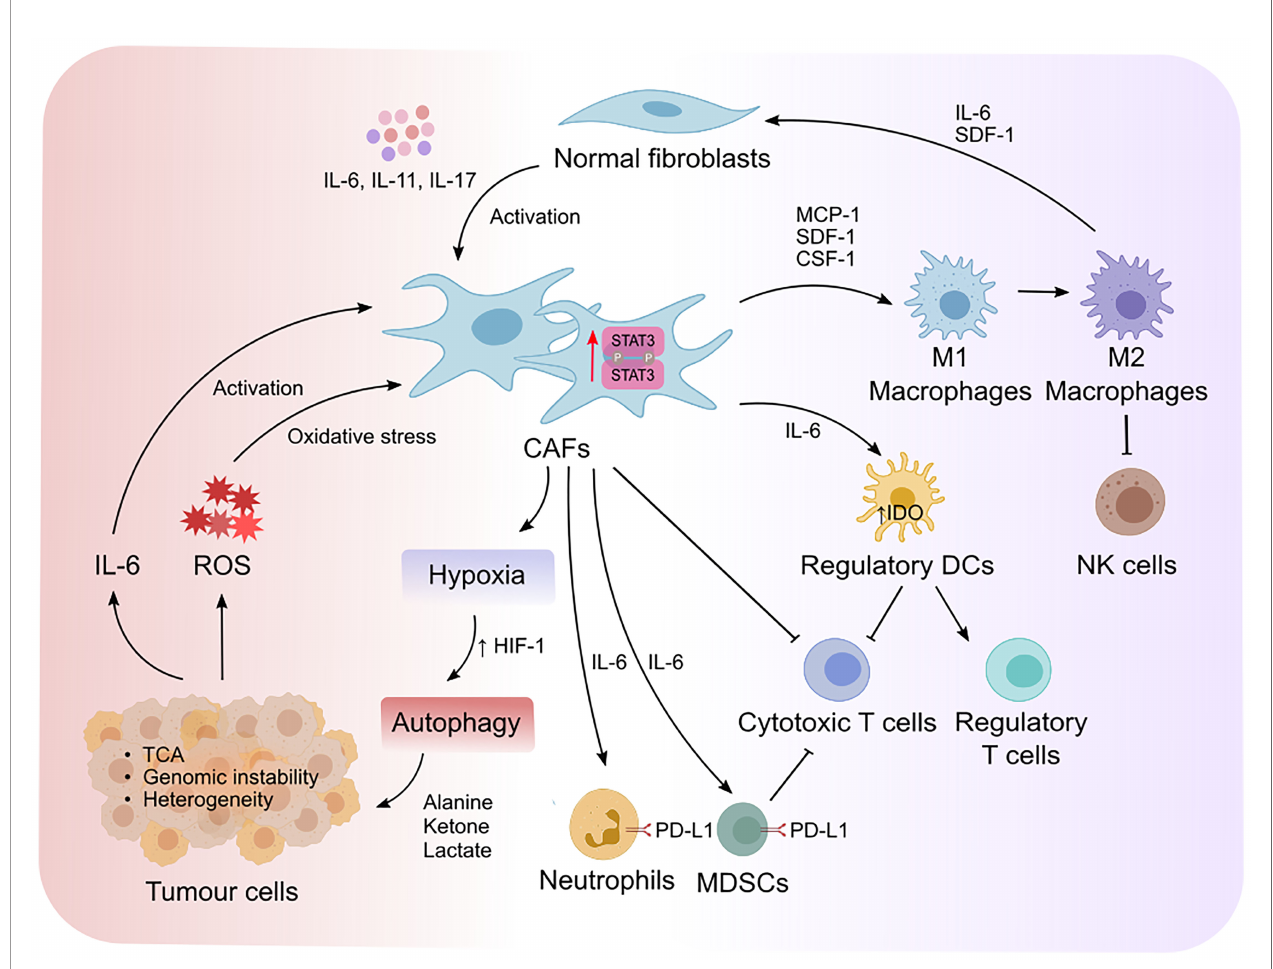
FIGURE 3 | STAT3 mediates reciprocal crosstalk between CAFs, tumor cells and immune cells in the TME. Cytokine-mediated activation of STAT3 promotes the transformation of normal fi broblasts to cancer associated fi broblasts (CAFs). STAT3 increases the expression of hypoxia-inducible factor-1 (HIF-1) that leads to hypoxia and autophagy. This results in the production of high energy products that fuel the tricarboxylic (TCA) cycle in tumor cells, as well as the production of IL-6 that form a positive feedback loop to enable further activation of CAFs. Moreover, elevated oxidative stress induced by tumor-derived reactive oxygen species (ROS) can induce genomic instability and promote tumor heterogeneity. On the other hand, STAT3-mediated activation of CAFs exert immunosuppressive effects via the recruitment and polarization of macrophages from an M1 to an M2 endotype, which suppresses the cytotoxic activity of natural killer (NK) cells. Moreover, CAFs recruit regulatory dendritic cells (DCregs) to inhibit the activation of cytotoxic T cells while simultaneously promoting the proliferation of regulatory T cells. IL-6/STAT3 signaling in CAFs also promotes the development of myeloid-derived suppressor cells (MDSCs) and induces PD-L1 expression in neutrophils. Collectively, deviation of cytokine mediated STAT3 activity in the TME alters the metabolic landscape of tumors and fosters an immunosuppressive environment that can evade immune